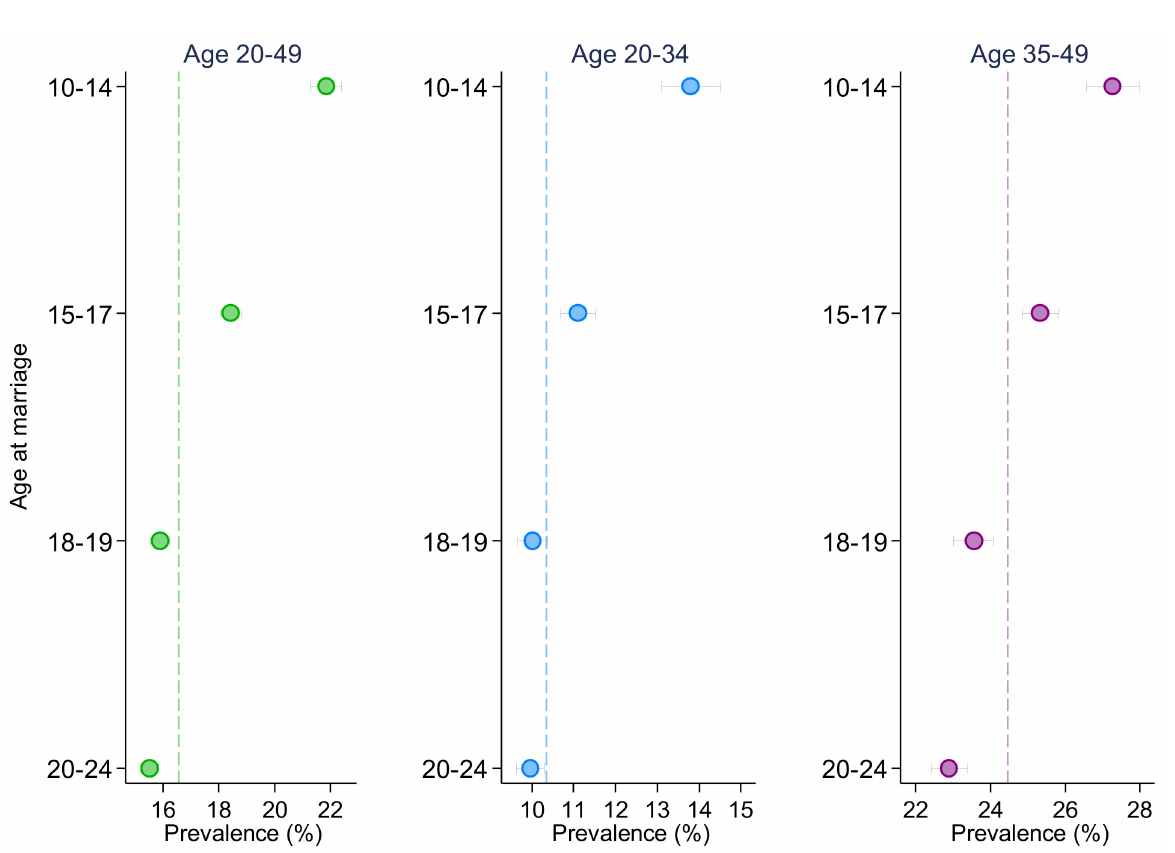
Figure 1. High blood pressure prevalence by age at marriage. Estimates were obtained using complex survey weights. The horizontal lines across the markers represent 95% confidence intervals. The vertical dashed lines represent the average high blood pressure prevalence rates in the respective age